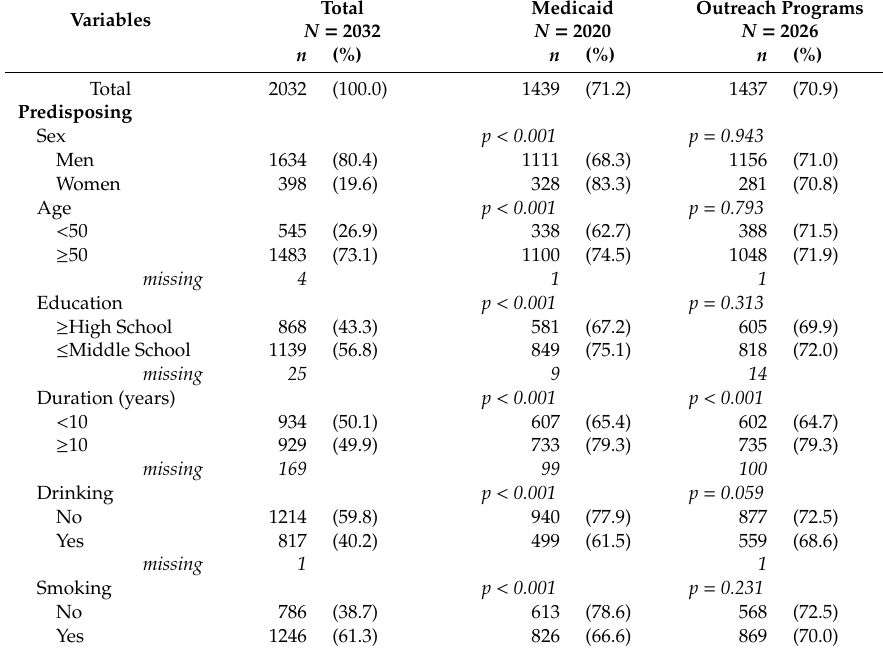
Table 1. The utilization of medical welfare service by three domains of Gelberg–Andersen behavioral model in homeless people, S.